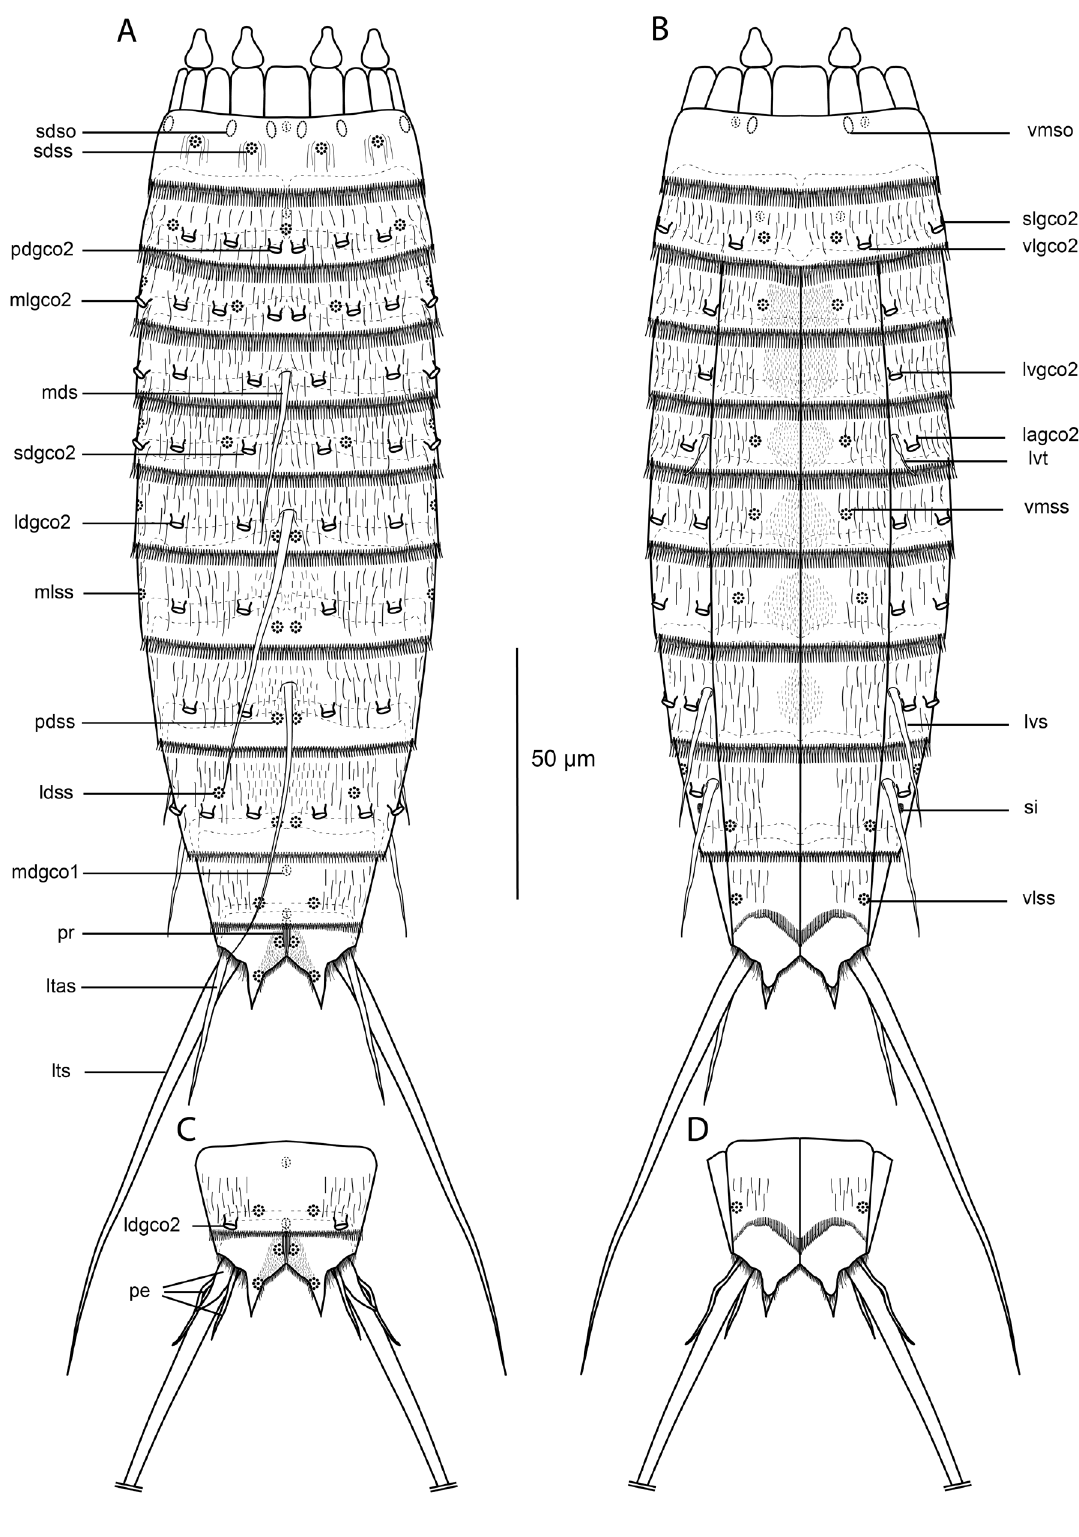
Fig. 26. Line art illustrations of Echinoderes aragorni sp. nov. A . ♀, dorsal view. B . ♀, ventral view. C . ♂, segments 10–11, dorsal view. D . ♂, segments 10–11, ventral view. Abbreviations: see Material and